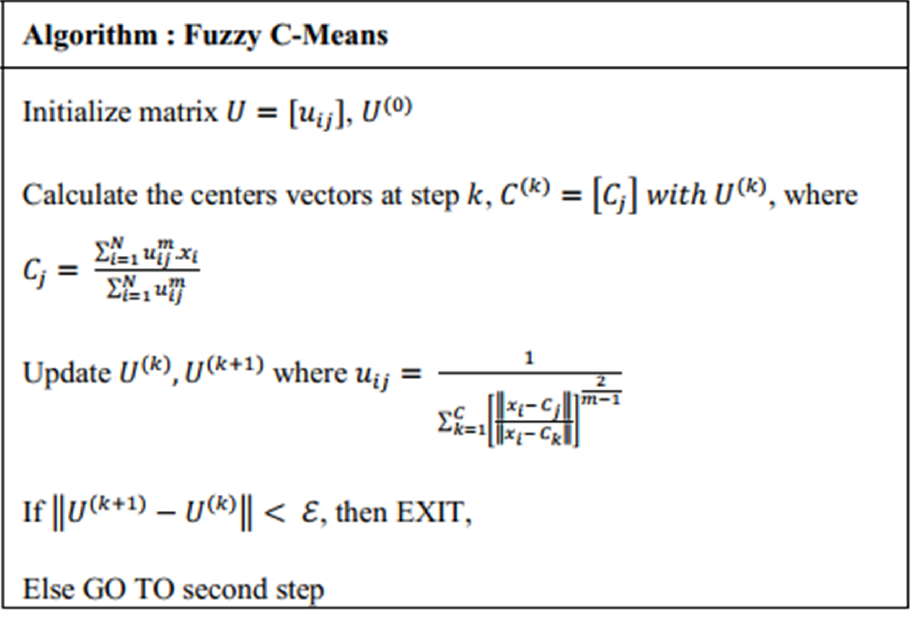
Figure 5. Fuzzy C-Mean algorithm [51].